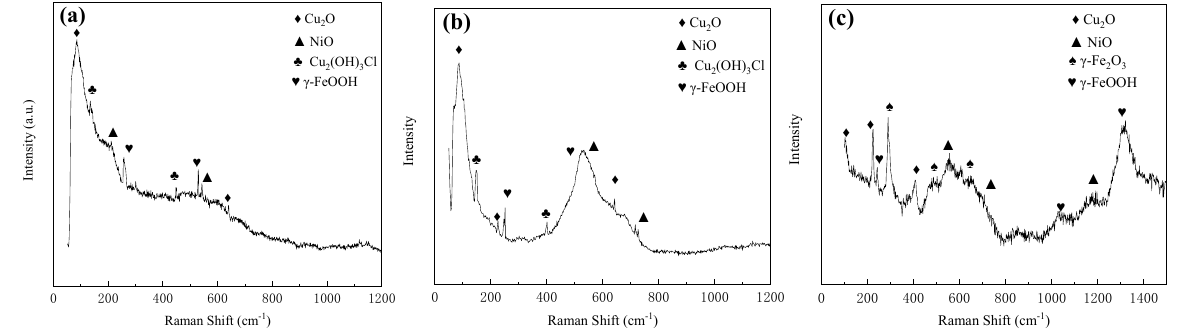
Figure 18. Raman spectra of corrosion production: ( a ) MZ, ( b ) HAZ and ( c ) WZ. XPS profiles of Cu, O, Cl, Ni and Fe within the sputtering depth of 0 − 2100 nm of HAZ are shown in Figure 19 after corroding in 3 ± 0.1 m/s and 5 ± 0.1 m/s seawater for 30 days.